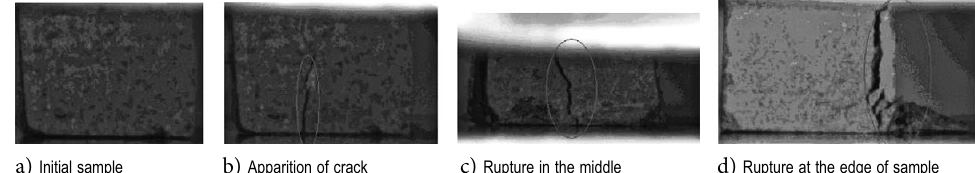
Fig. 9. Apparition configurations of